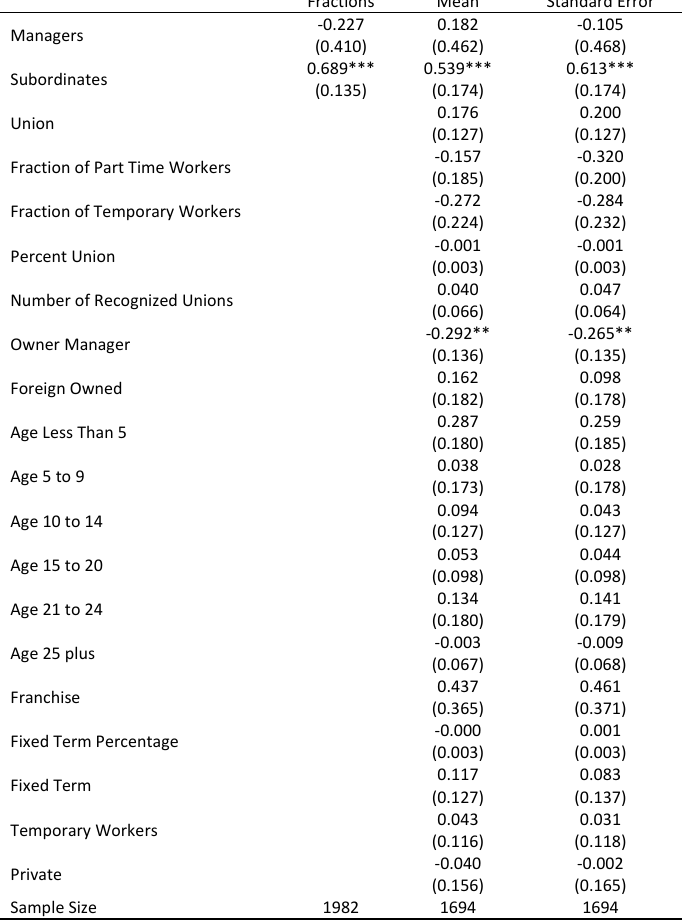
Table 2: Ordered probit models (dependent variable = internal hiring)